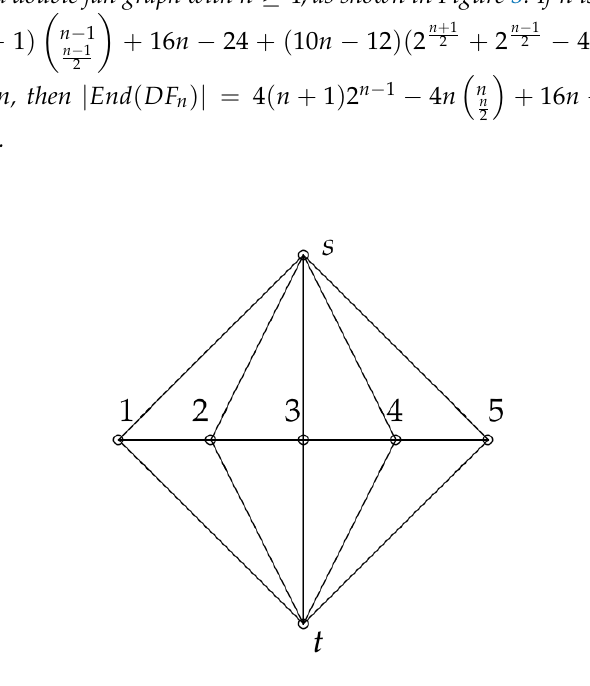
Figure 3. Graph DF 5